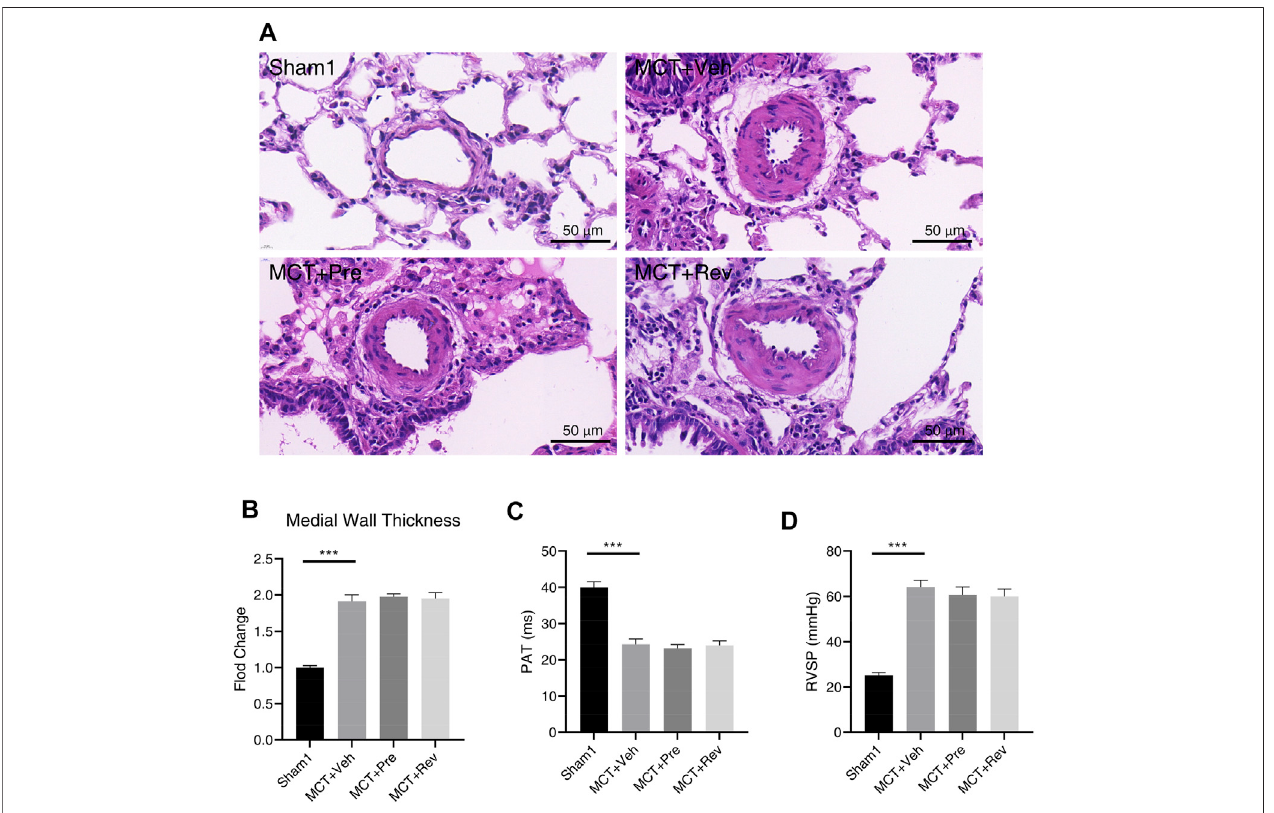
FIGURE 4 | Dapagli fl ozin could not alleviate pulmonary vascular remodeling in MCT rats. (A) Representative images of H and E staining in the lung sections; Quanti fi cationofmedialwallthickness (B) ,PAT (C) ,RVSP (D) fi veweeksafterMCTinjection.(*** p < 0.001; n (cid:1) 6forSham1, n (cid:1) 10forMCT+vehicle,MCT+prevention, and MCT +